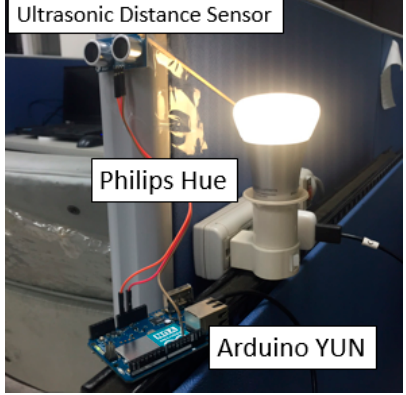
Figure 17. The prototype of a smart office light system.